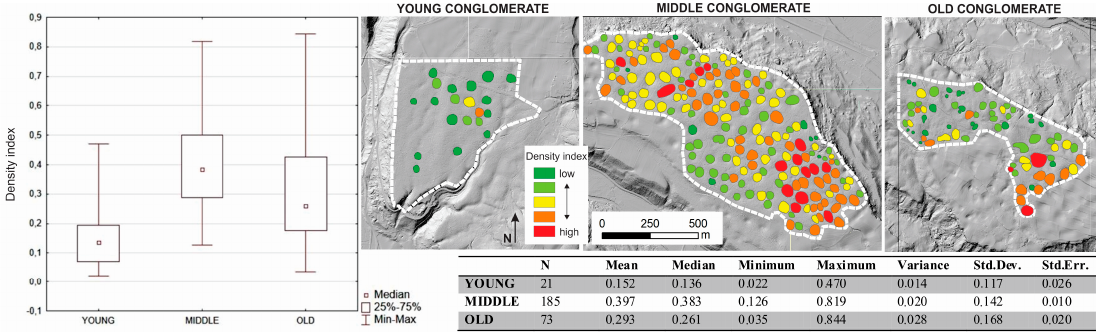
Figure 15. Doline distribution by the age of conglomerate index represented by density index.